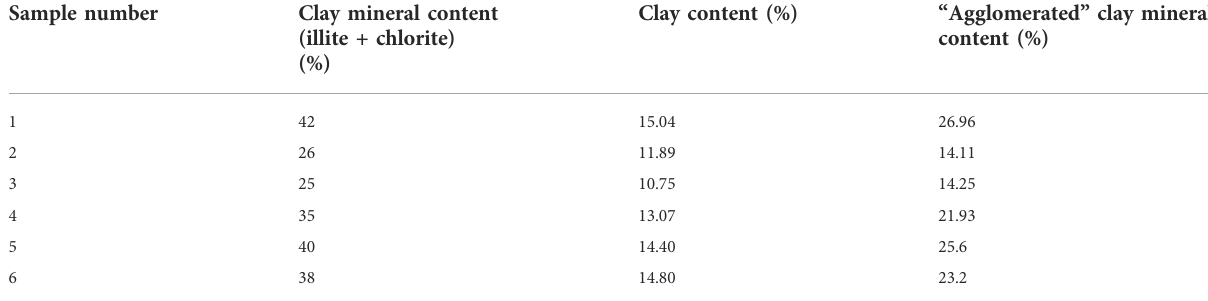
TABLE 6 Percentage of “ agglomerated ” clays in each sample. Sample